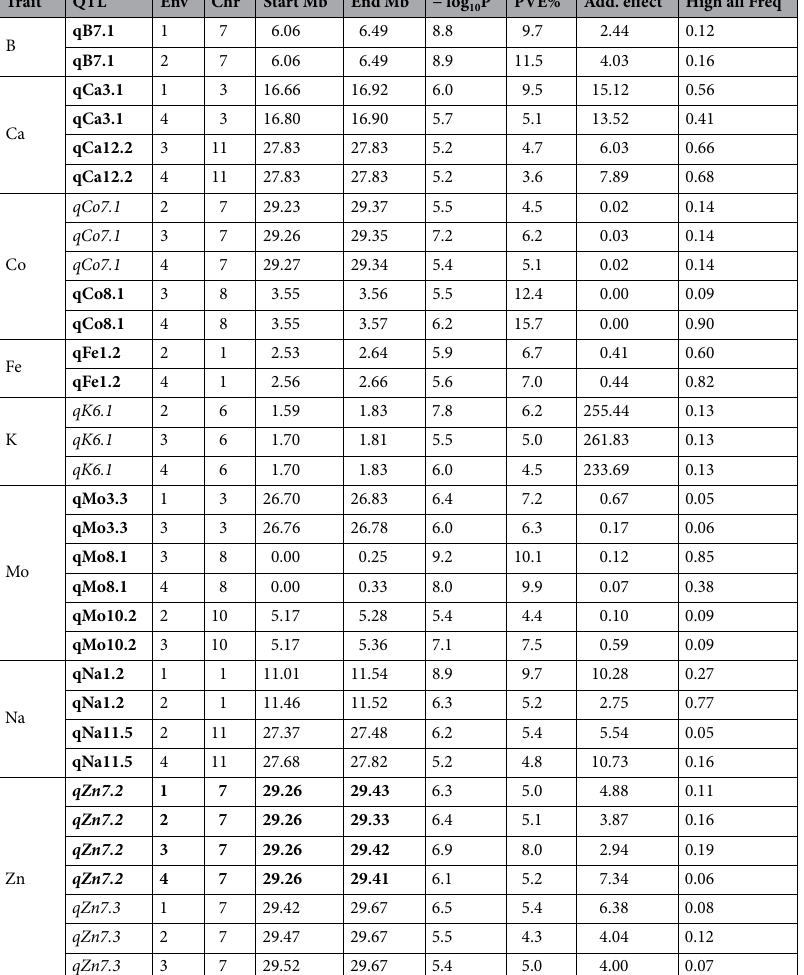
Table 2. Summary of the stable QTL detected in 2, 3 and 4 environments (highlighted in bold, italics and bolditalics, respectively. Env environment (1 = IRRI 2012, 2 = IRRI 2013, 3 = PhilRice2012, 4 = PhilRice2013), Chr chromosome, Start/End physical Mb position of the linkage block, Add Effect: estimated additive effect, PVE phenotypic variation explained by the QTL (%), High all Freq Frequency of the higher value